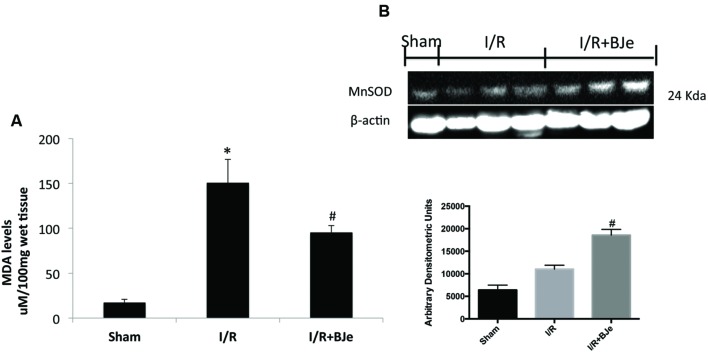
Effect of BJe on MDA levels and MnSOD expression. Reperfusion of the ischemic splanchnic circulation leads to a profound increase in MDA levels in ileum tissues from I/R subjected mice treated with vehicle (A). MDA levels were reduced by BJe treatment (A). In addition, the expression of an antioxidant enzyme MnSOD, was also evaluated by western blot (B). The expression of MnSOD was increased in BJe treated mice compared to vehicle group (B). Basal expression was found in sham mice (B). A representative blot of lysates (B) obtained from 10 animals/group is shown, and densitometry analysis of all animals is reported. Data are means ± SEM of 10 mice for each group. ∗P < 0.05 vs. SHAM; #P < 0.05 vs. I/R.